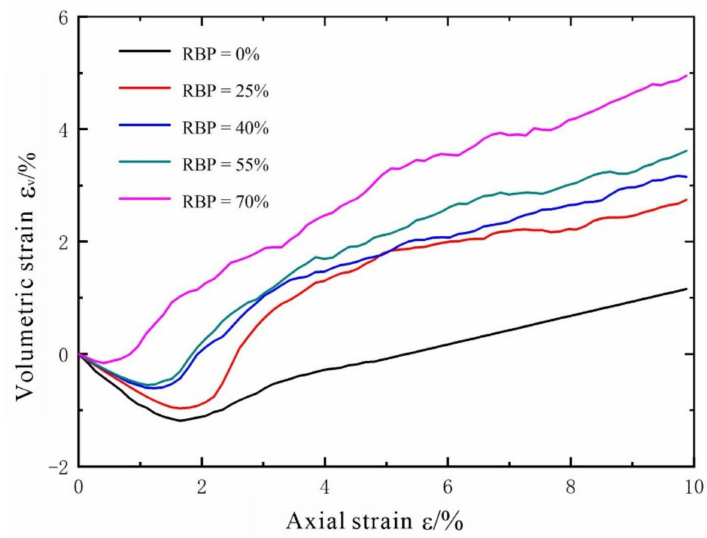
Figure 7. Relationship between volumetric strain and axial strain.